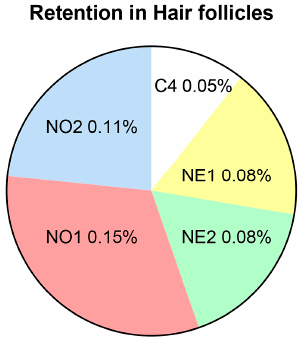
Figure 4. Minoxidil retained in hair follicles (as % of applied dose) from 60% ethanol solution and nanoemulsions. Actual minoxidil delivery ranged from 7.5 µg/cm 2 (C4) to 22.5 µg/cm 2 (NO1). p < 0.05 for NO1 (oleic acid nanoemulsion) versus 60% ethanol solution (C4); other comparisons not significant.